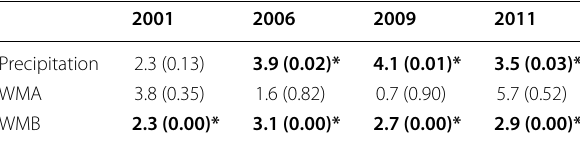
The values in bold with stars are statistical significance at 90%